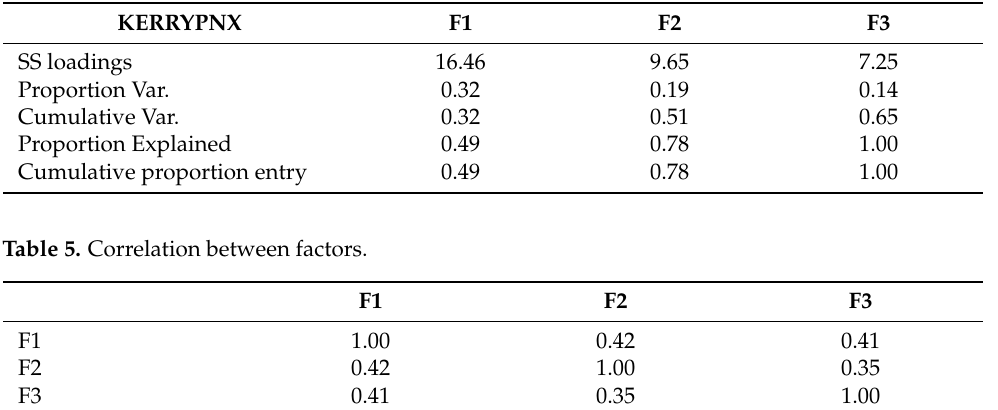
Table 4. Measures of factor adequacy.